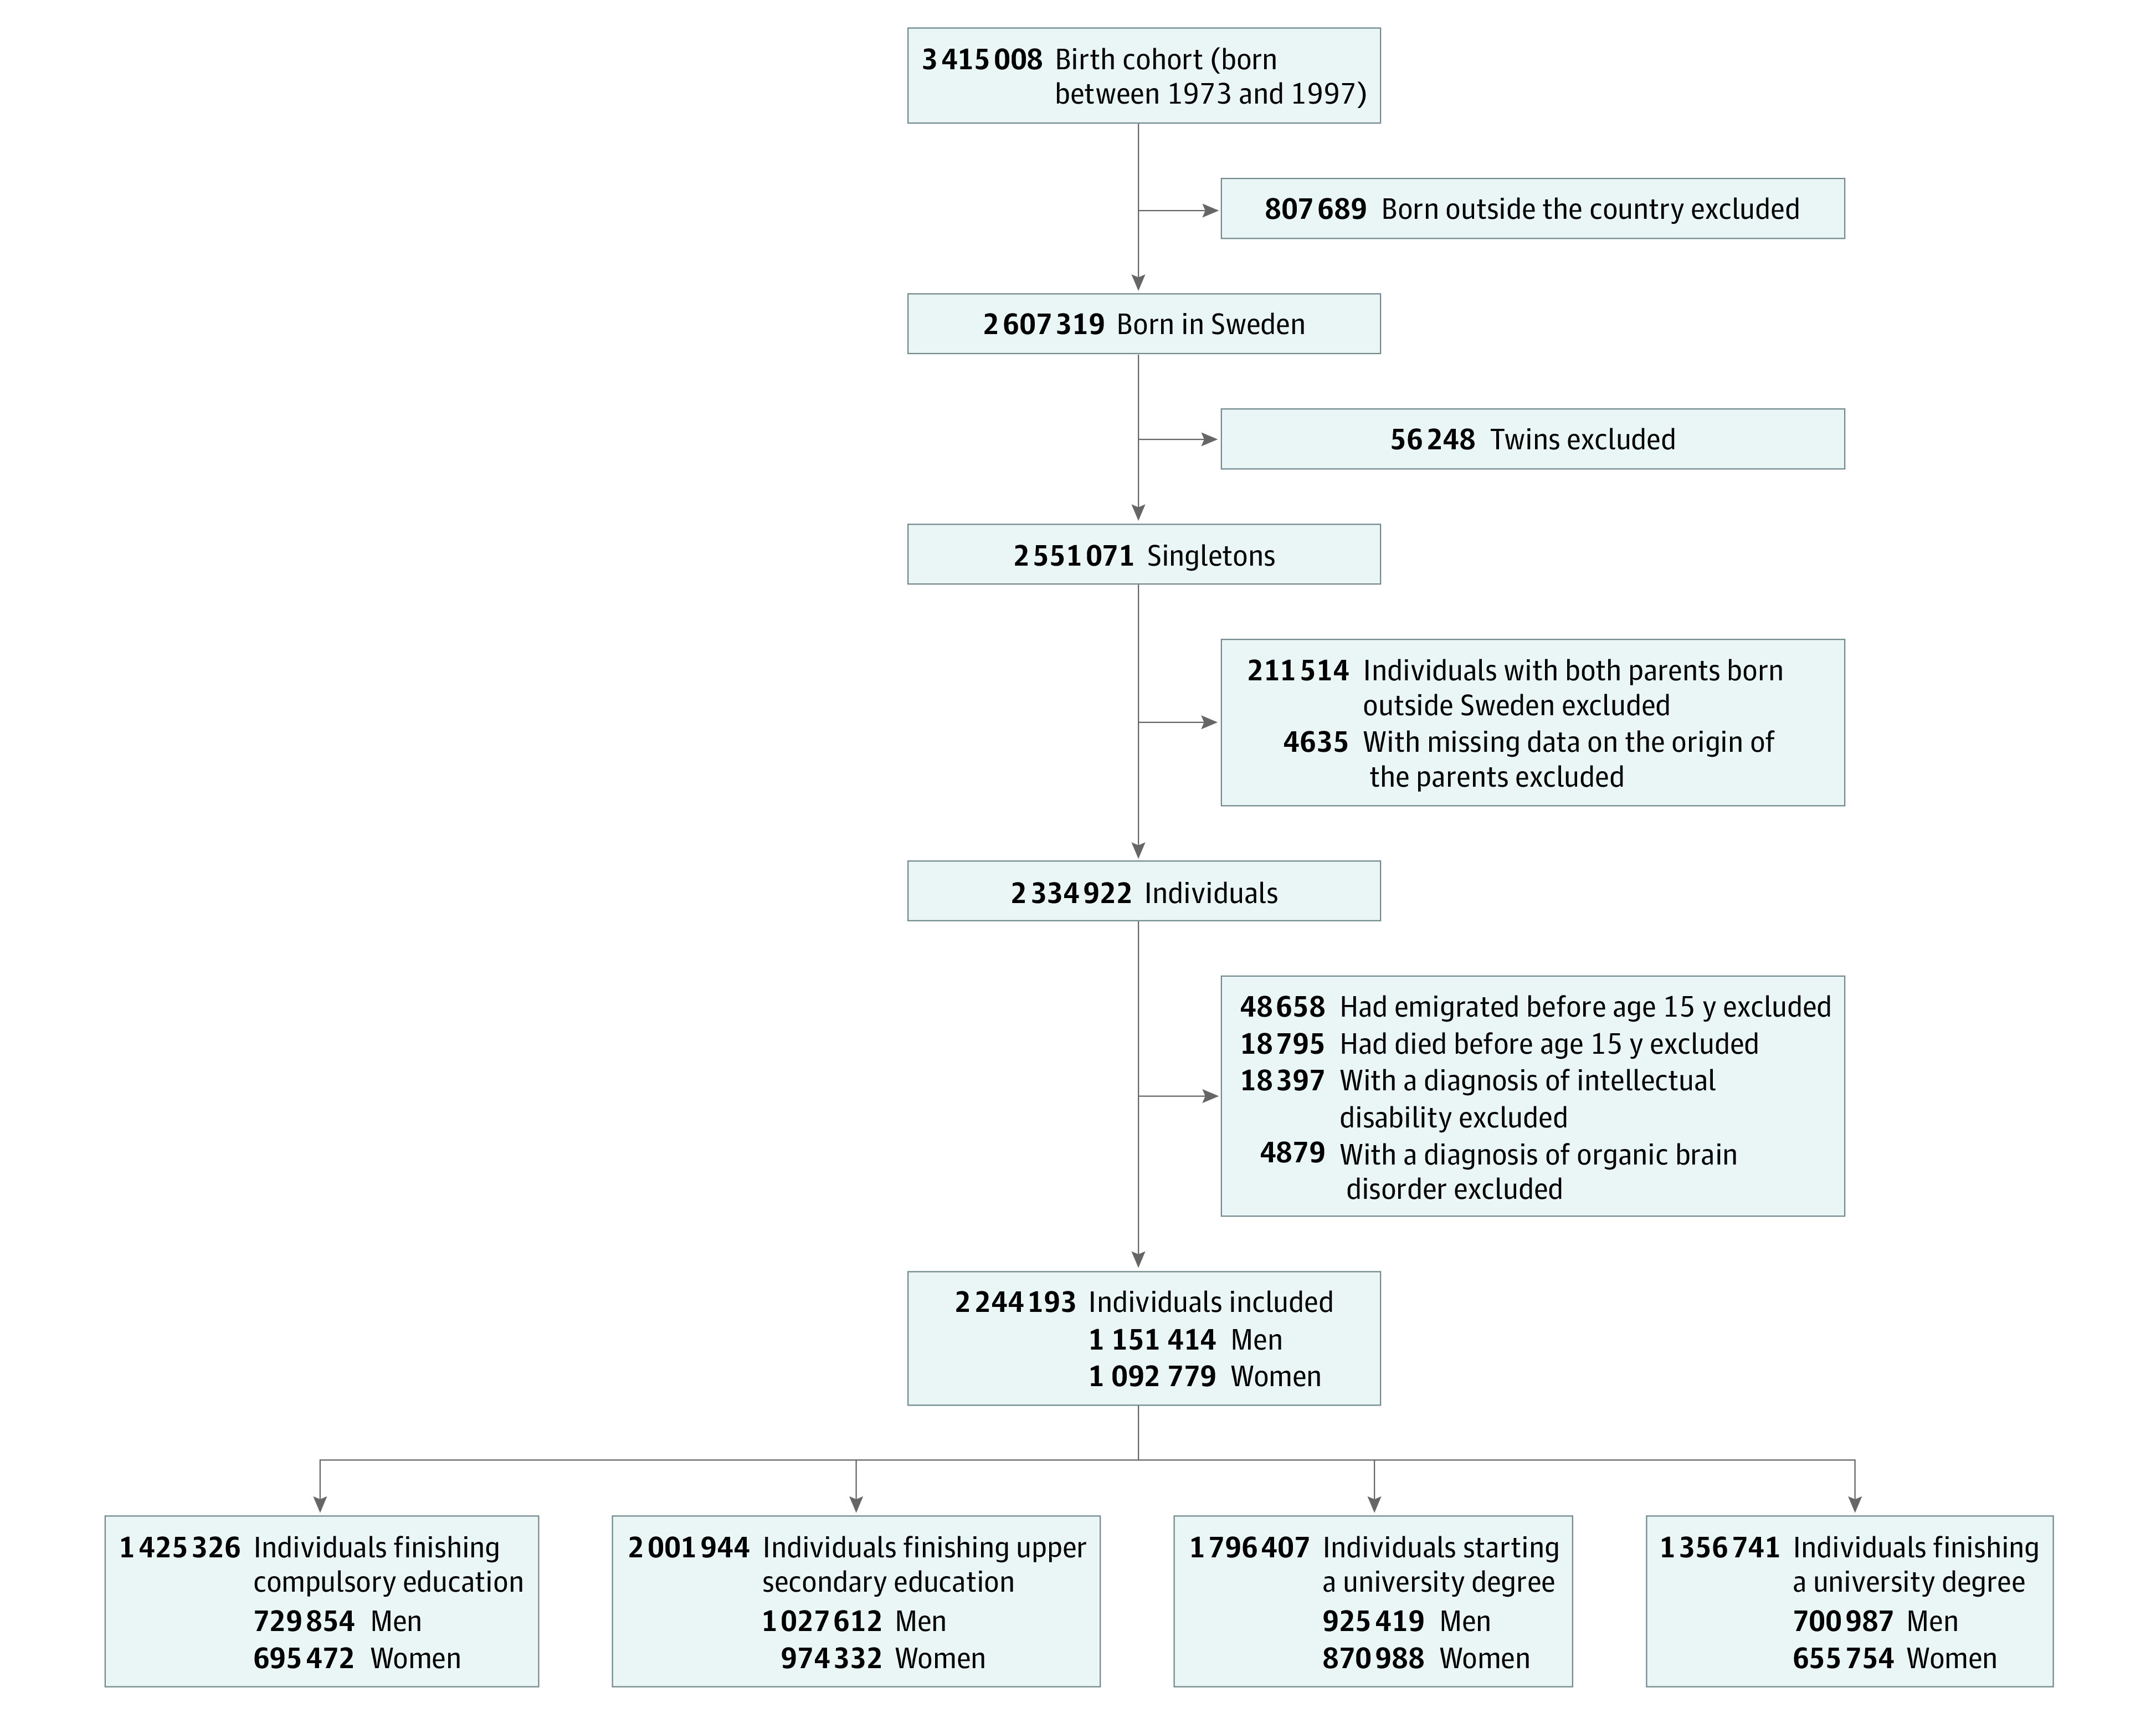
Flowchart of the Study PopulationThe final study cohort comprised 2 244 193 individuals (51.3% male and 48.7% female).